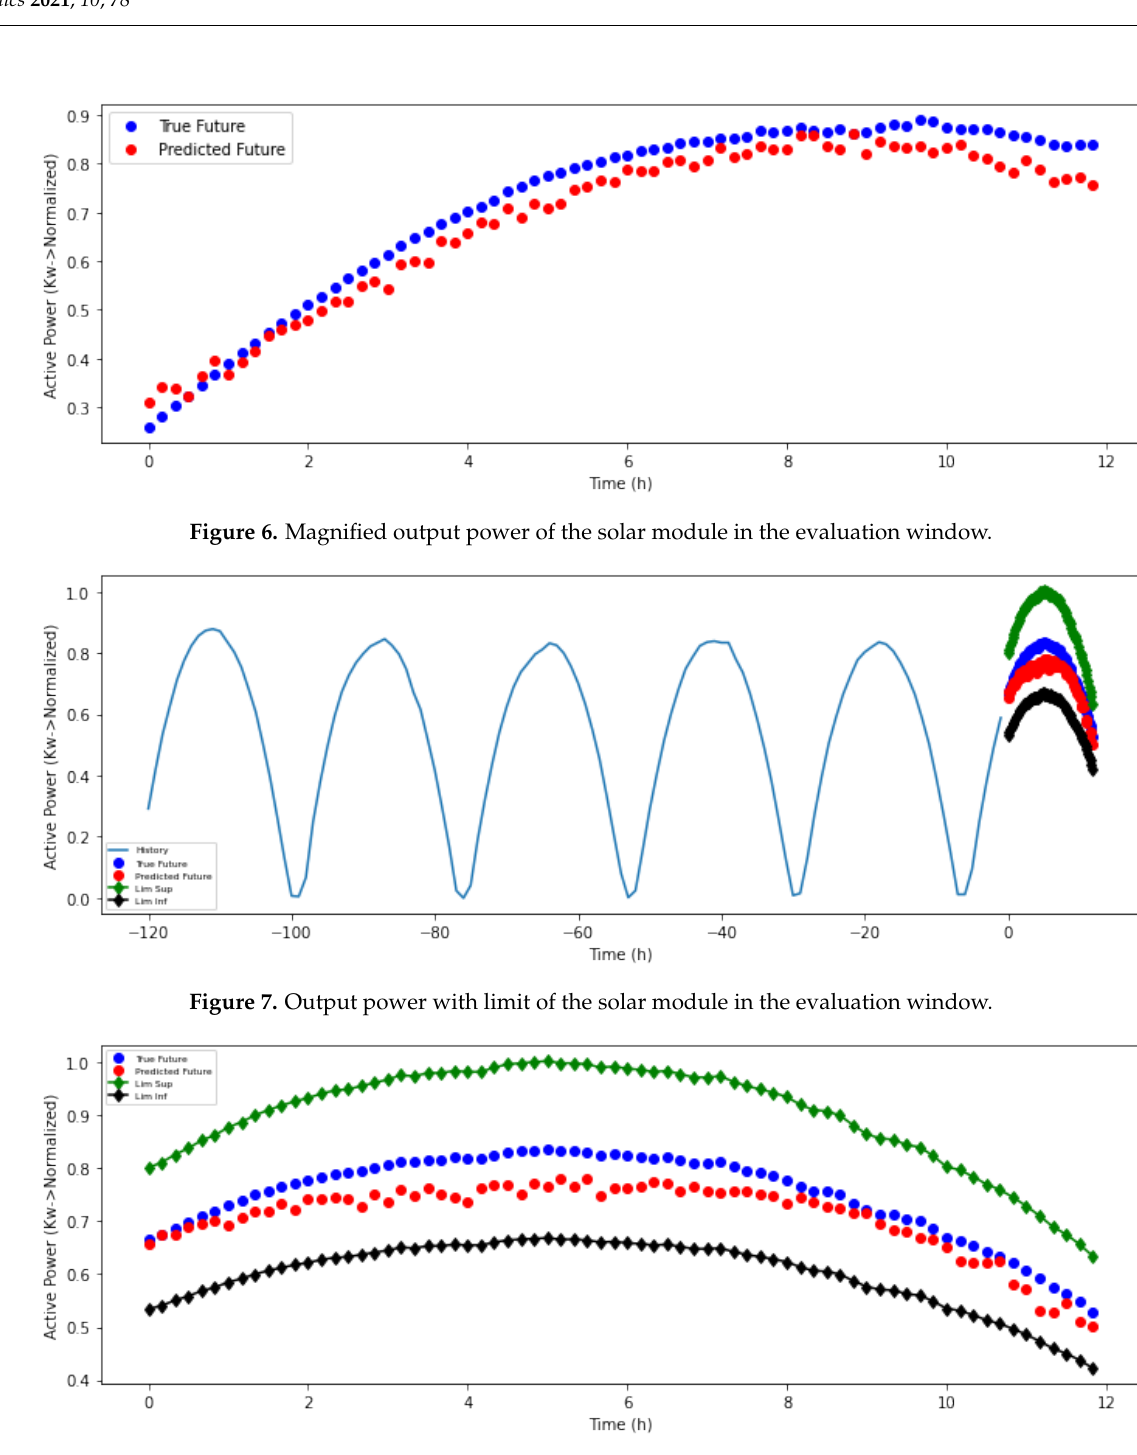
Figure 8. Extended output power with limit of the solar module in the evaluation